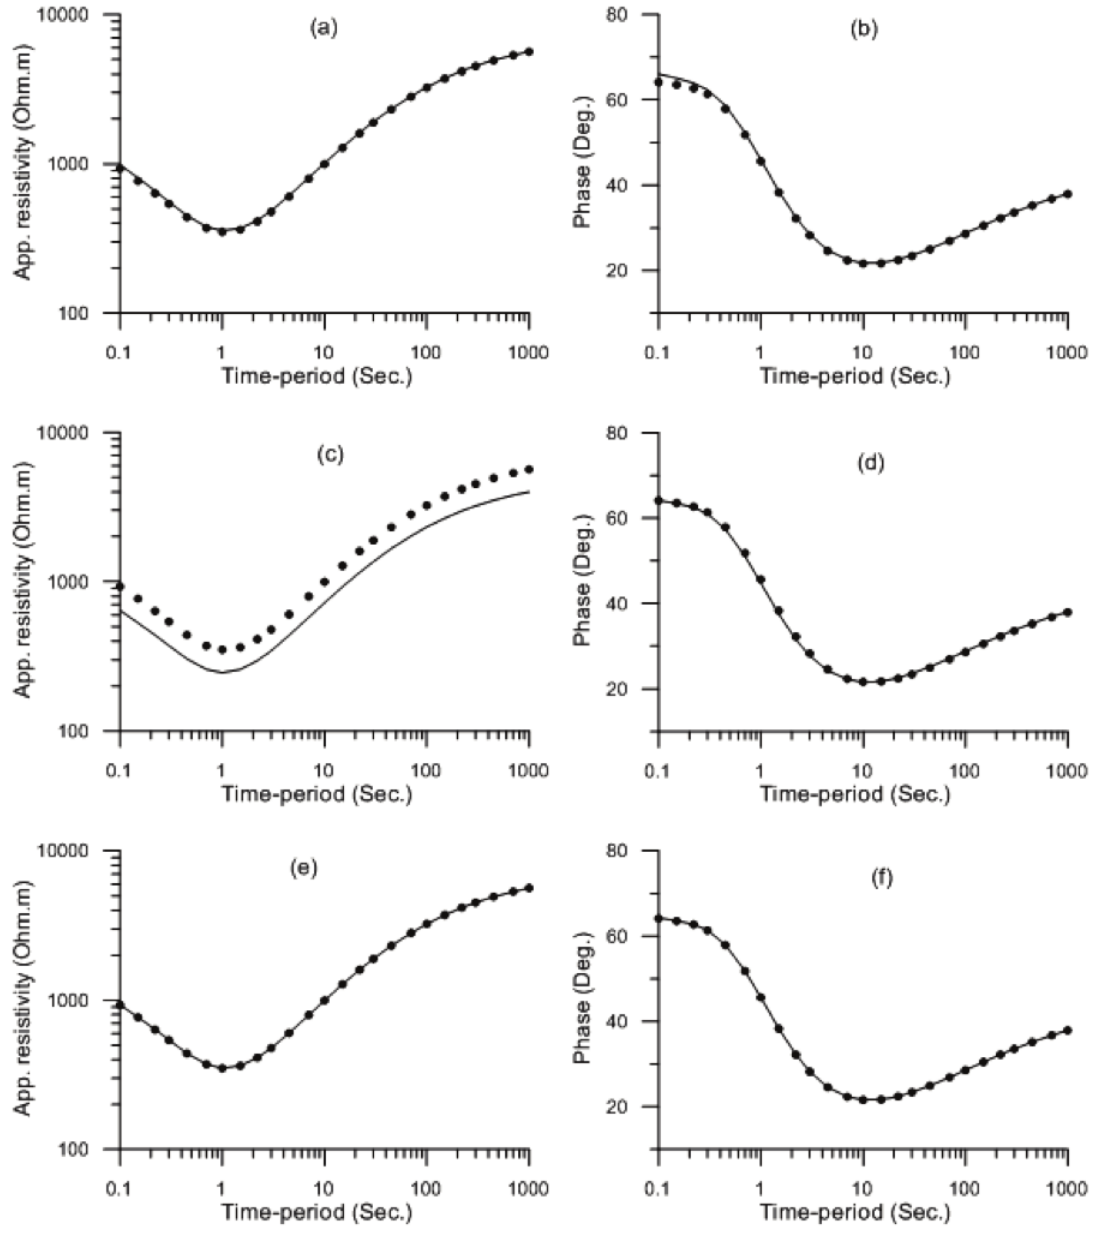
Figure 2. Comparisons between observed data (solid symbols) and model data (lines) for model 1 after inversion of the apparent resistivity data (a, b), the phase data (c, d) and both sets of data (e,